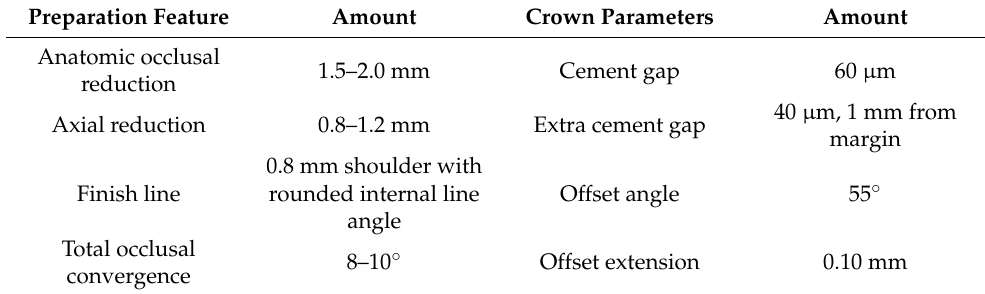
Table 1. Preparation features and crown